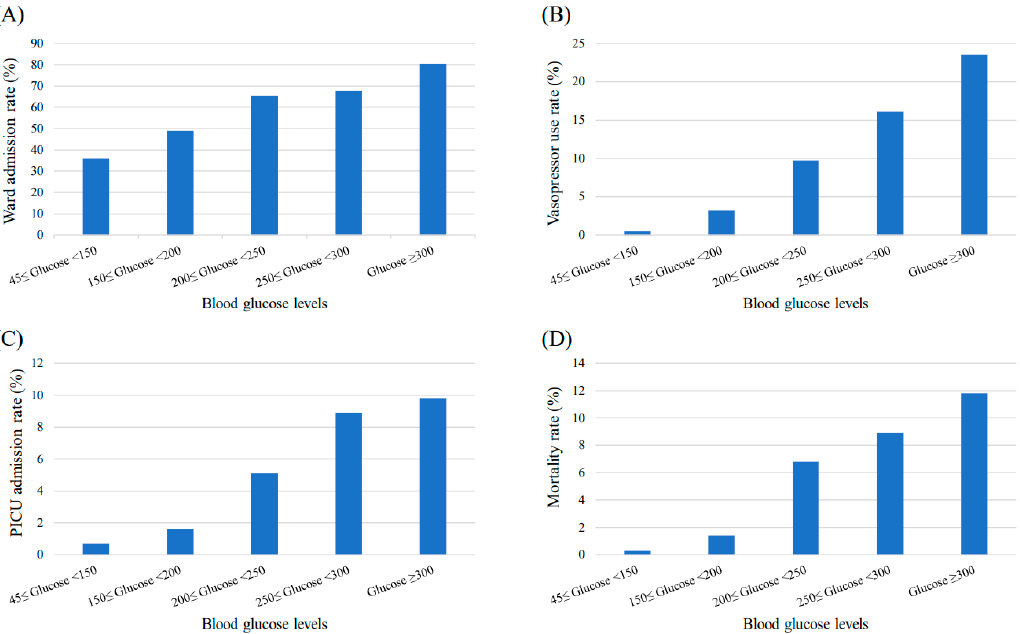
Figure 2. Changes in patient outcomes according to blood glucose levels. The ( A ) ward admission rate, ( B ) vasopressor use rate, ( C ) PICU admission rate, and ( D ) mortality rate of patients visiting the PED increase significantly as the blood glucose levels increase ( p < 0.001). Abbreviations: PICU, pediatric intensive care unit; PED, pediatric emergency department. Table 3. Logistic regression analysis of patient outcomes with blood glucose levels ( n =